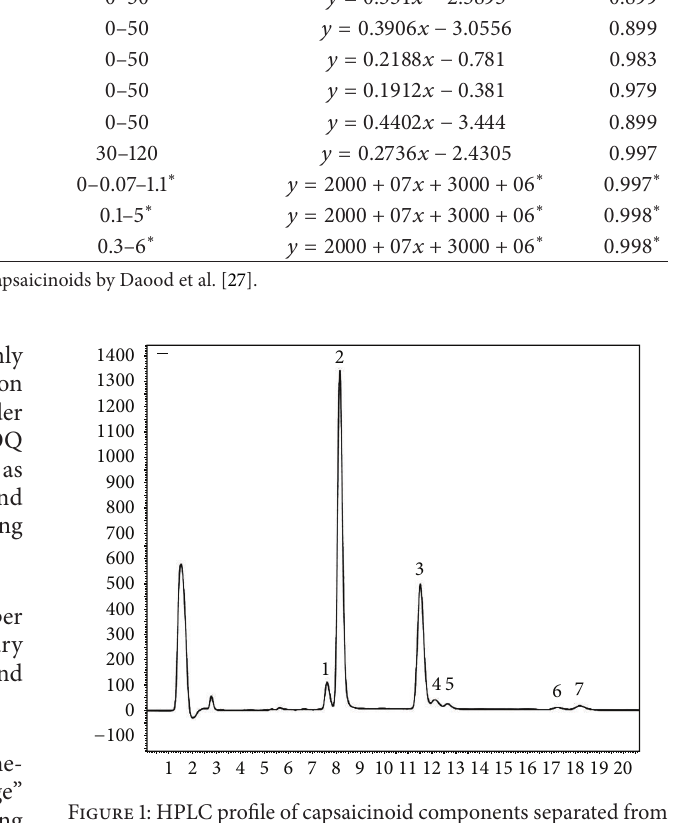
Figure 1: HPLC profile of capsaicinoid components separated from red stage of Bandai hybrid using cross-linked C18 column with acetonitrile-water elution and fluorescence detection. 1: NDC, 2: CAP, 3: DC, 4: HCAP1, 5: HCAP2, 6: HDC1, and 7: HDC2. For more information see